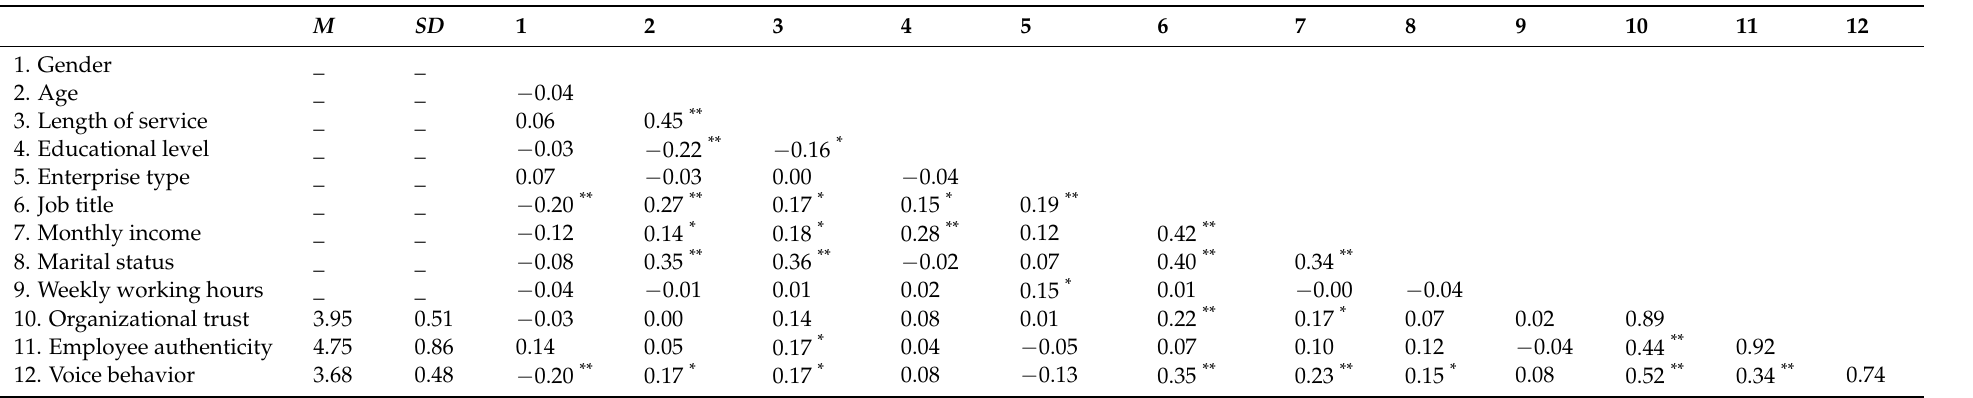
Table 1. Descriptive statistics and correlations among variables ( n =